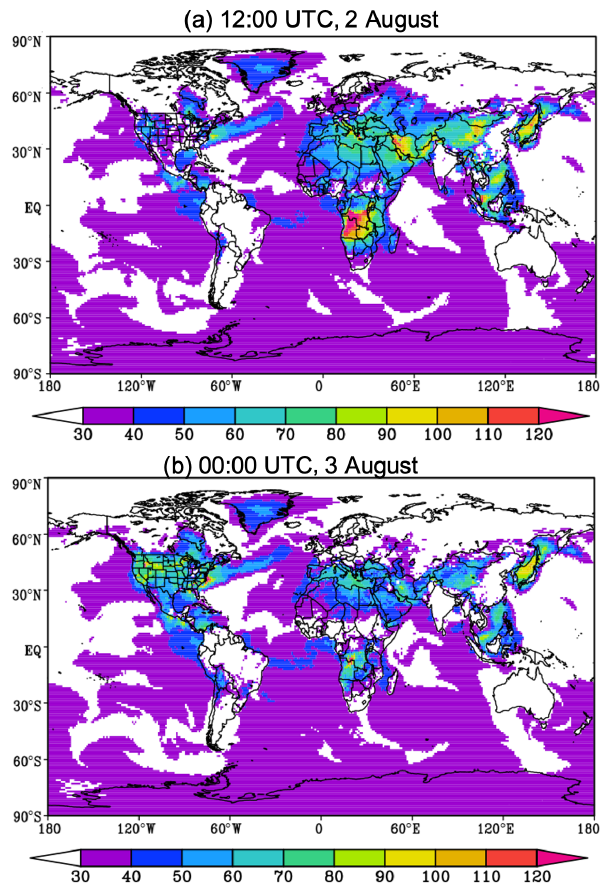
Figure 4. The 5d forecast starting from 00:00UTC on 29 July 2016 of surface O 3 using RACM_GOCART scheme at (a) 12:00UTC on 2 August and (b) 00:00UTC on 3 August 2016. Unit: